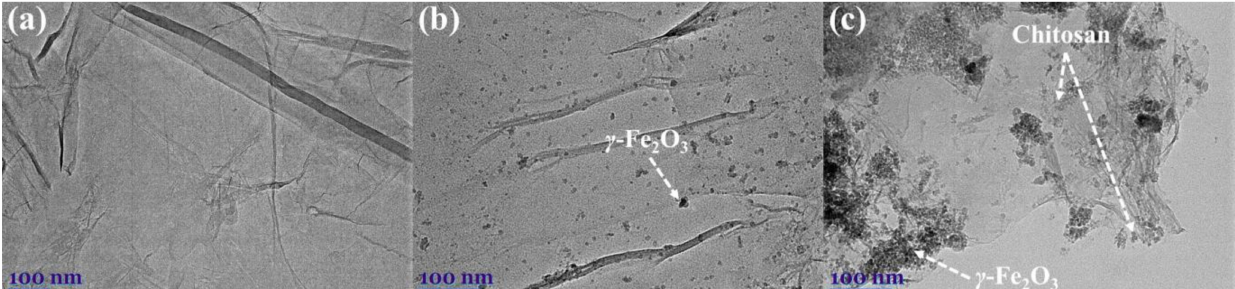
Figure 5. The TEM images of GO ( a ), GO-MGH ( b ), and GO-MGH-CS ( c